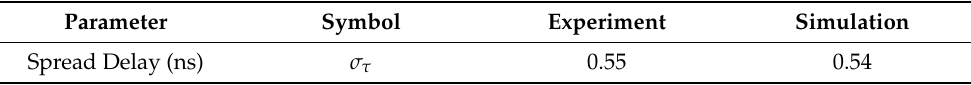
Table 8. Summary